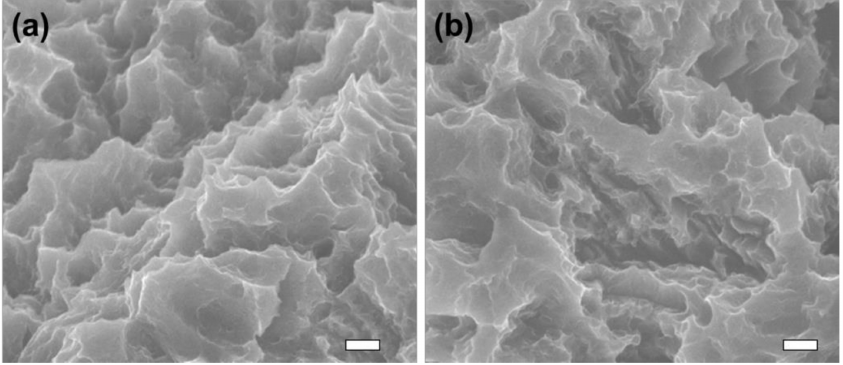
Figure 4. Scanning electron microscopy images of titanium implant before ( a ) and after ( b ) non- thermal atmospheric pressure plasma jet (NTAPPJ) treatment. Scale bar is 2 µ m.